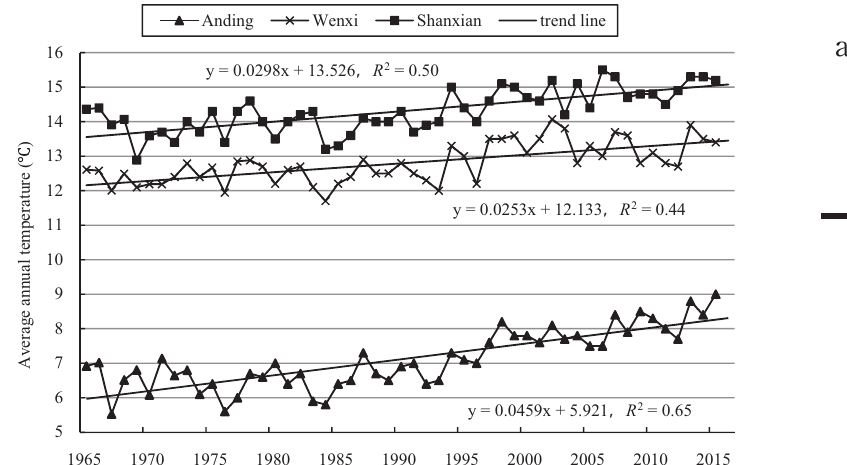
y = 0.0459x + 5.921 ， R 2